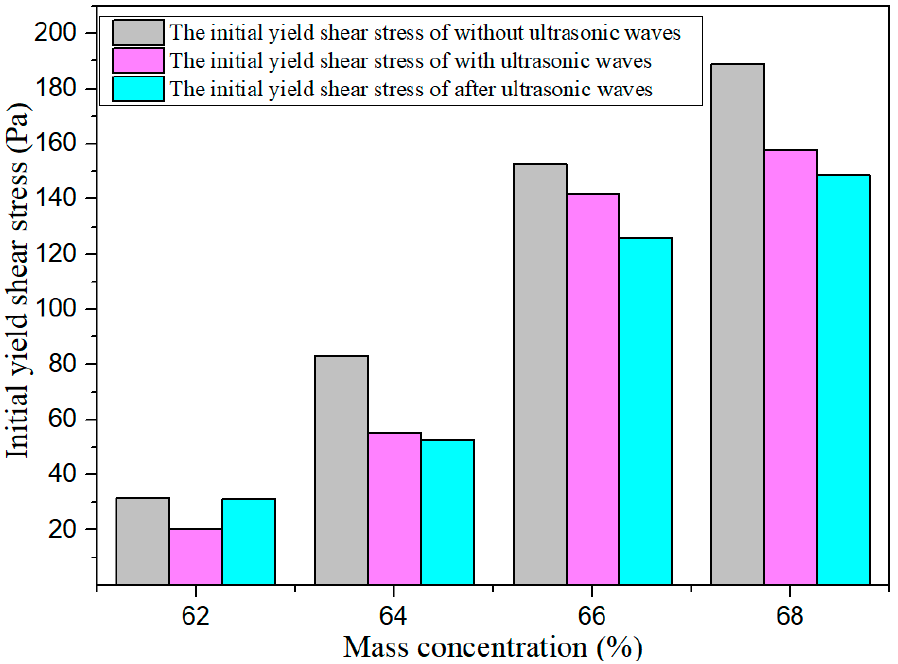
Figure 8. Initial yield shear vs. mass concentration curves of UCPB.